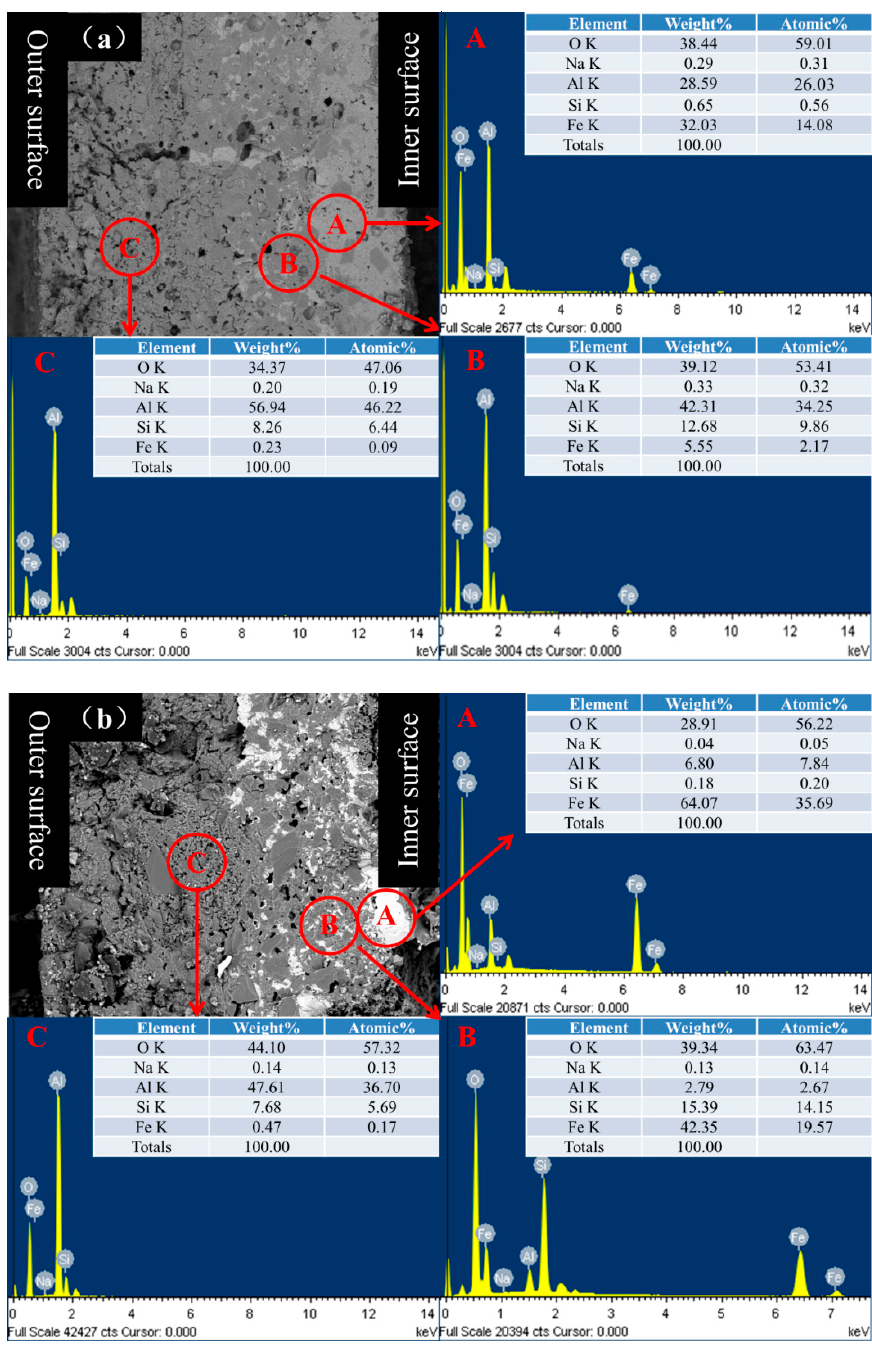
Figure 10. SEM-EDS images of cross-sections belonging to ( a ) the sample protected by ASMA and ( b ) the sample protected by AS at 1250 °C.